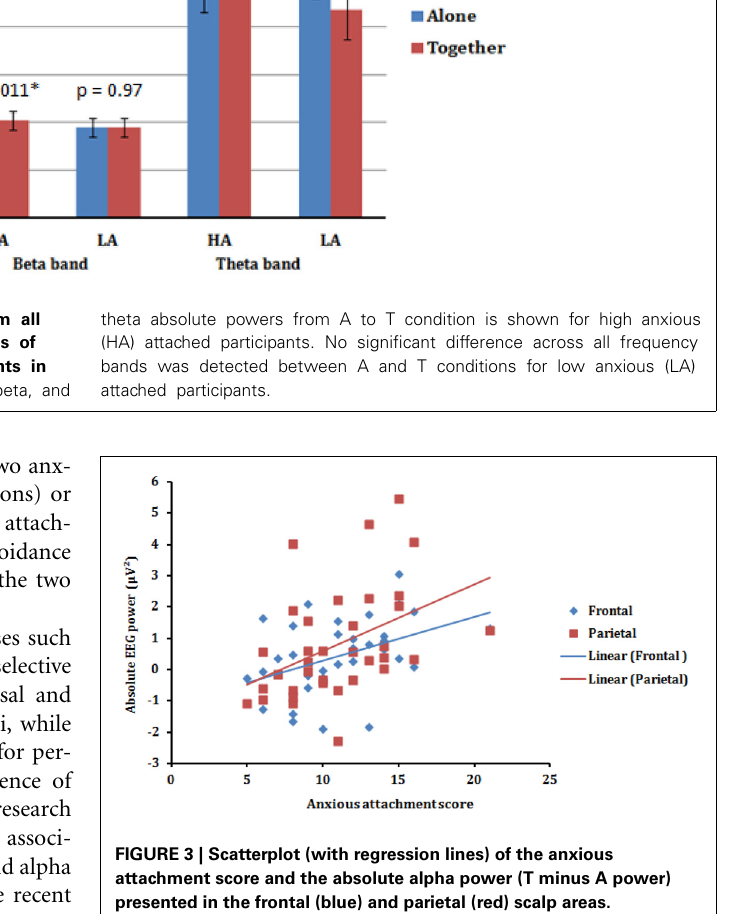
FIGURE 3 | Scatterplot (with regression lines) of the anxious attachment score and the absolute alpha power (T minus A power) presented in the frontal (blue) and parietal (red) scalp